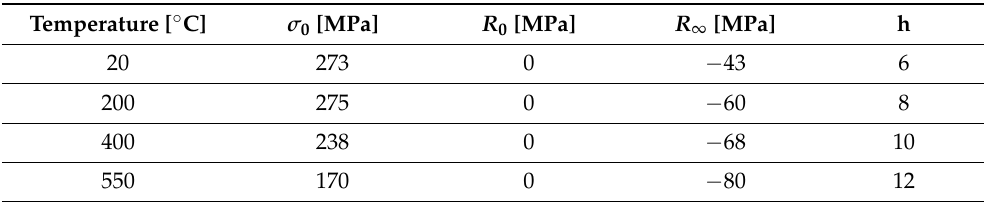
Table 2. Voce model parameters for CuCrZr